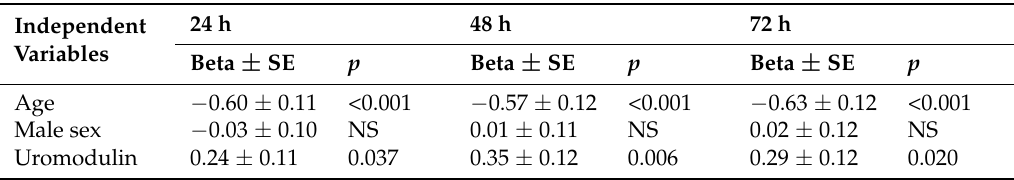
Table 3. Multiple linear regression showing the associations between serum uromodulin and eGFR during first 72 h of acute pancreatitis: eGFR was the dependent variable in the models, while age and sex were included as the